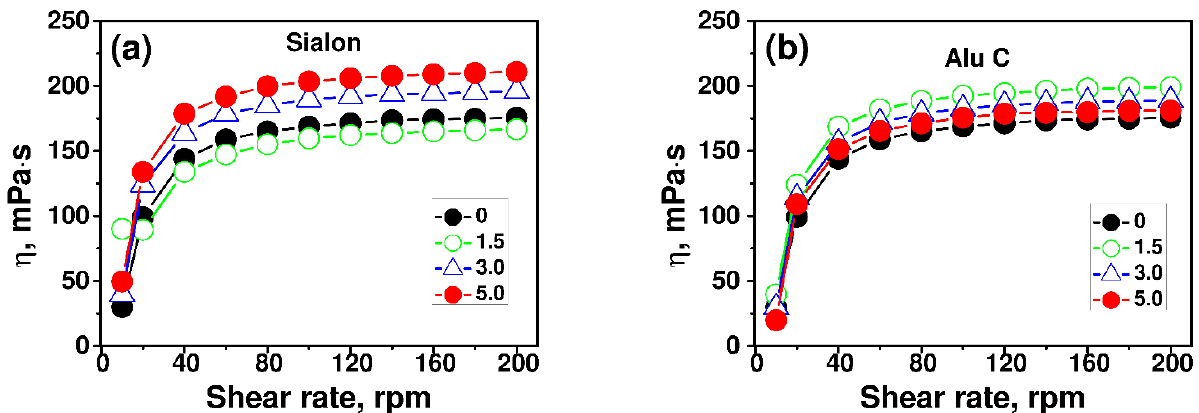
Figure 3. The viscosity of the formulation as the function of the shear rate and the filler content at 25 °C; ( a ) Sialon, ( b ) Alu C. The numbers indicate the filler content as weight percent. The lines are guides to the eye.